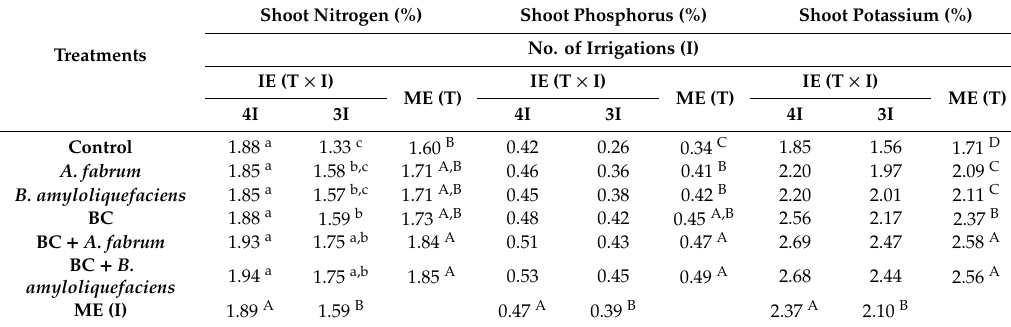
Table 5. E ff ect of Agrobacterium fabrum , Bacillus amyloliquefaciens with / without biochar (30 Mg ha − 1 ) on nitrogen, phosphorus and potassium concentration in wheat shoot cultivated in drought-stressed field conditions *.